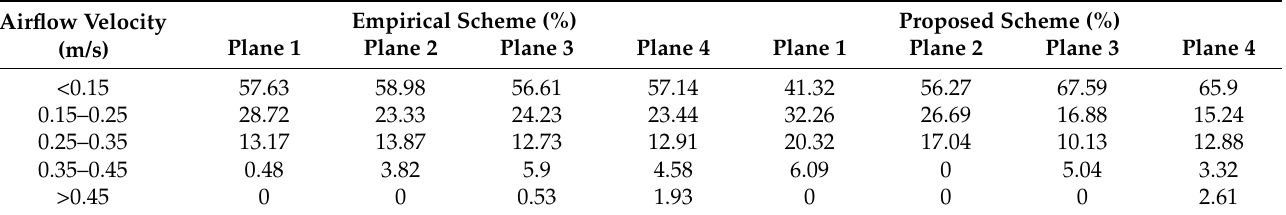
Table 7. Comparison of percentages of velocity distribution for the proposed and traditional empirical system